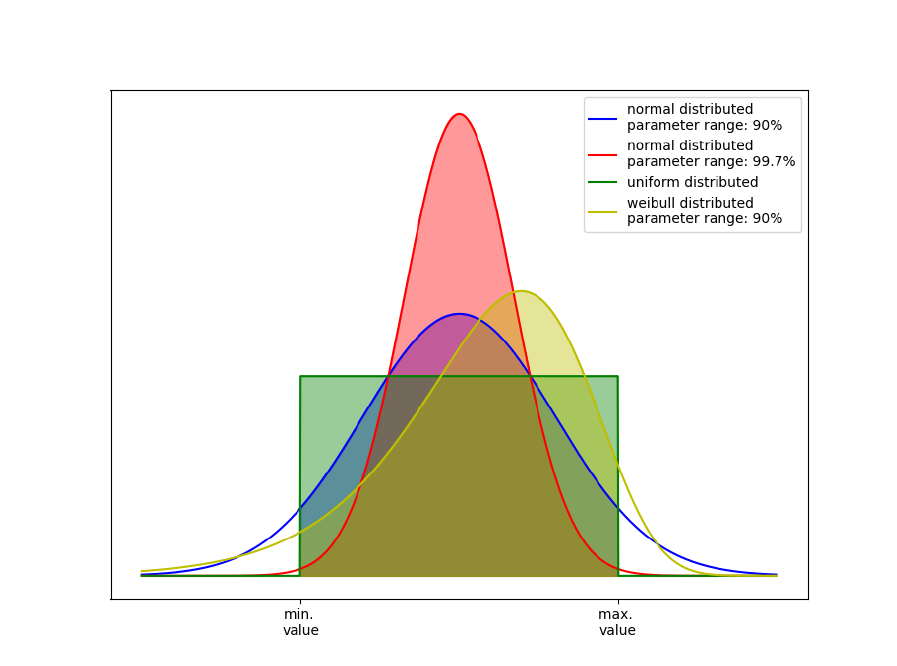
Figure 2. Illustration of the distribution types for a given value range defined in terms of the min. and max. value.